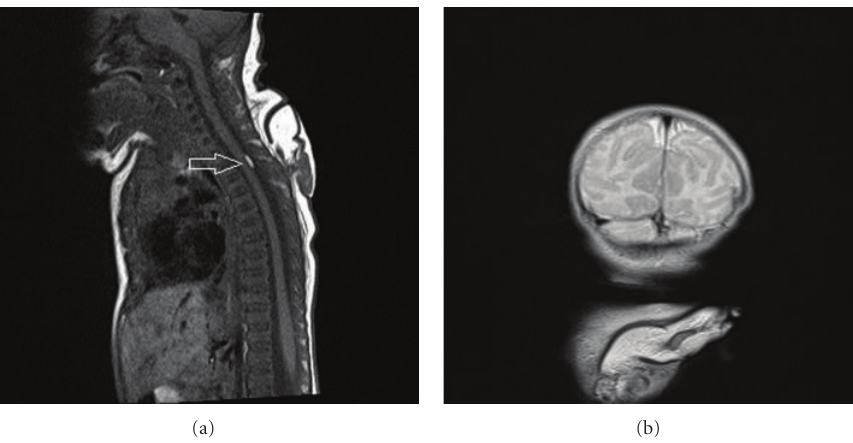
Figure 3: T1-weighted sagittal (a) and T2-weighted coronal (b) images. Arrow points that the lipoma is located at the same level of the ectopic extremity. Medulla Spinalis terminates between L3 and L4 vertebrae. Ectopic extremity originates from subcutaneous soft tissues and it does not extend deeper neural elements. It ends interspinous ligament. Coronal T2-weighted image shows dorsally located extremity, composed of fat and muscle tissue. Note that cerebral structures are in normal